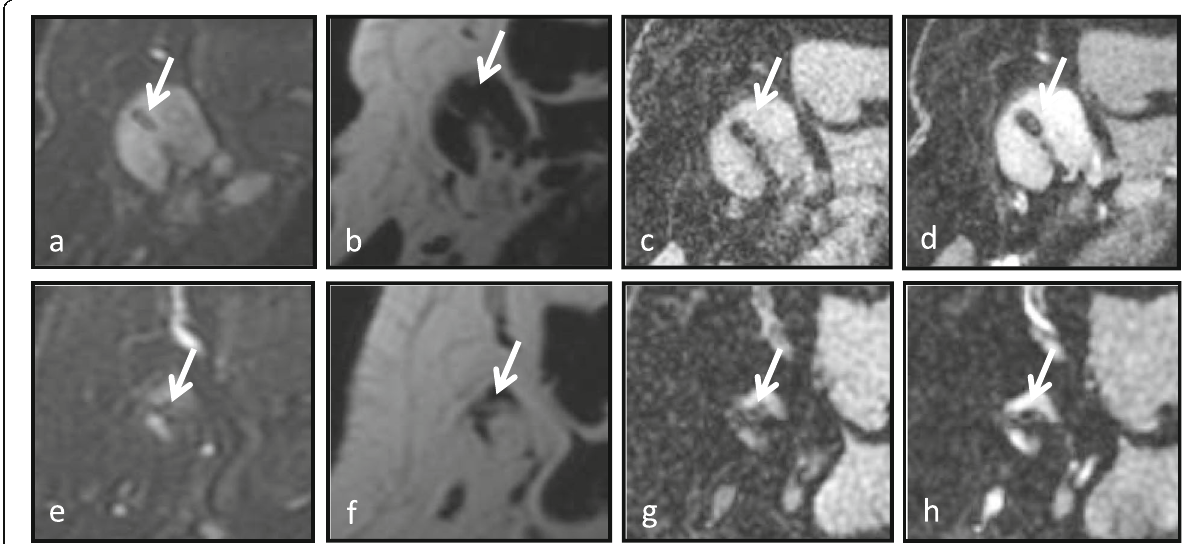
Fig. 2 A 49-year-old female with invasive lobular carcinoma of the right breast with biopsy proven right axillary metastatic lymphadenopathy. A Tumark x-shaped marker was placed at site of axillary lymph node biopsy. a – d Initial staging magnetic resonance imaging (MRI) 2 weeks after lymph node marker placement. The marker is seen with high confidence on the T2-weighted water-only fast spin-echo image ( a ), the unenhanced fat-suppressed three-dimensional T1-weighted spoiled gradient-recalled image ( c ), and the first contrast-enhanced fat-suppressed three-dimensional T1-weighted spoiled gradient-recalled image ( d ), while it is seen with low confidence on the T2-weigheted fat-only fast spin- echo image ( b ). In the follow-up of neoadjuvant therapy, MRI was performed 6 months after biopsy marker placement. The marker is seen with low confidence on all images: T2-weighted water-only fast spin-echo image ( e ), T2-weighted fat-only fast spin-echo image ( f ), unenhanced fat- suppressed three-dimensional T1-weighted spoiled gradient-recalled image ( g ), and first contrast-enhanced fat-suppressed three-dimensional T1- weighted spoiled gradient-recalled image ( h ), with poor visualization attributed to the decreased size of lymph node cortical